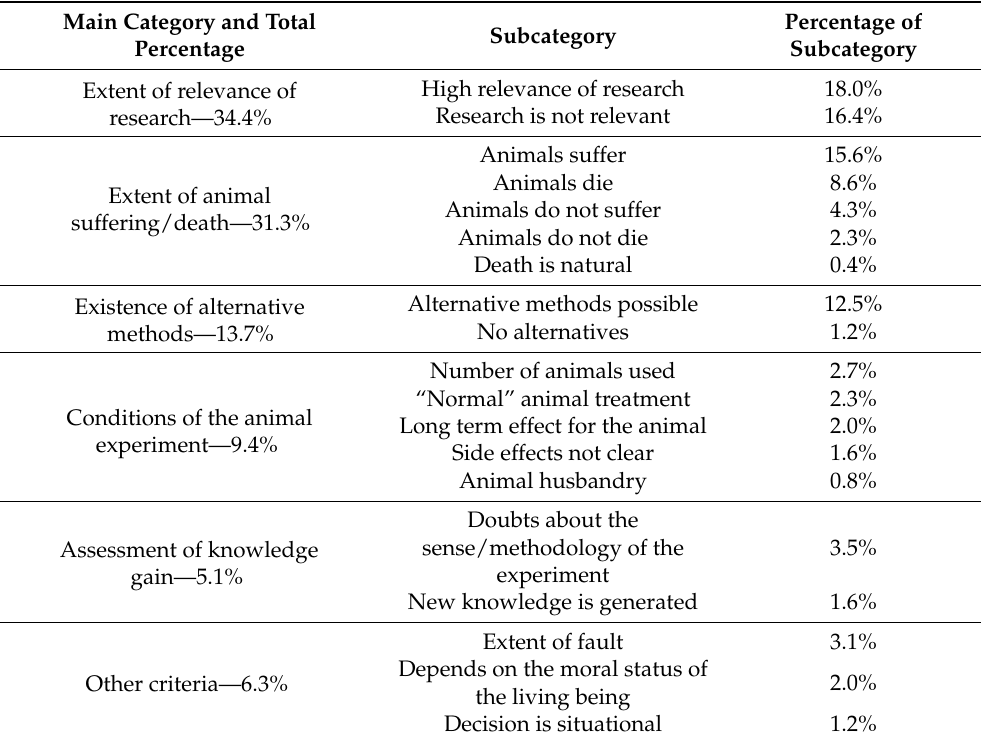
Table 1. Overview of the criteria the students used to evaluate animal experimentation. The data is presented with the percentage of main category and subcategory frequency of the qualitative content analysis. IRR Krippendorff’s Alpha =